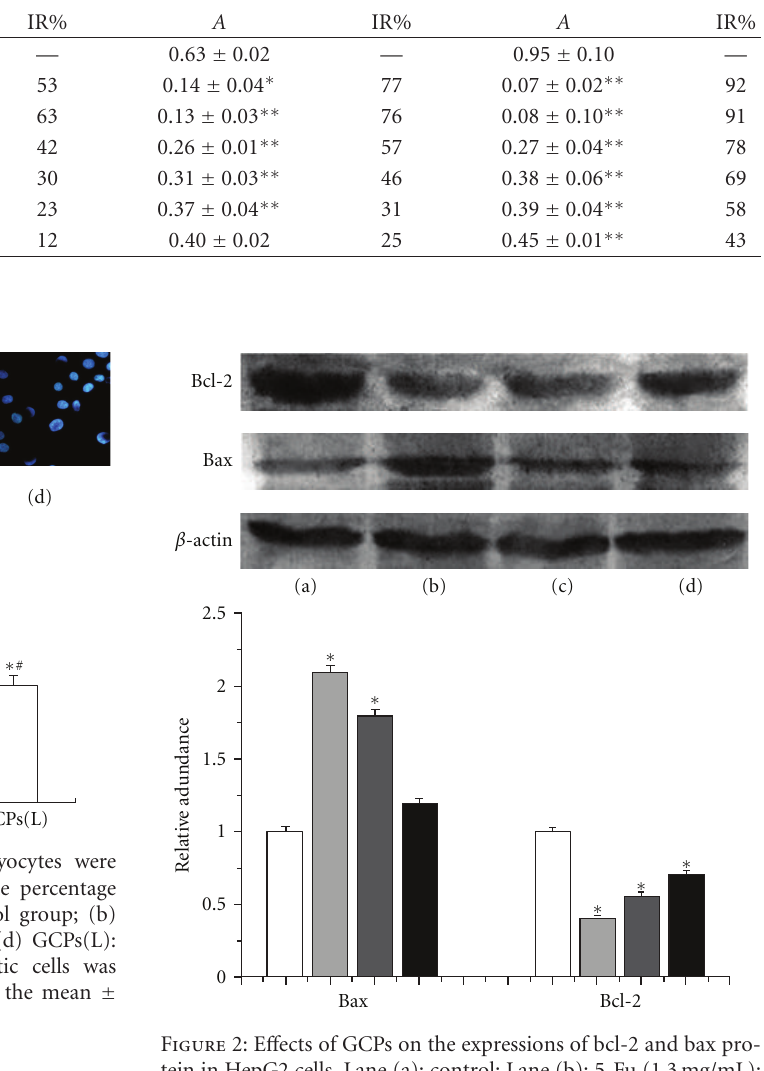
Figure 1. The NS group did not display any morphological features of apoptosis (Figure 1(a)). The typical changes associated with apoptotic cells appeared in GCPs-treated cells after 48 h incubation, the nuclei of apoptotic cells showed significant apoptosis in 1.6 and 0.8 mg/mL GCPs- treated cells (Figures 1(c) and